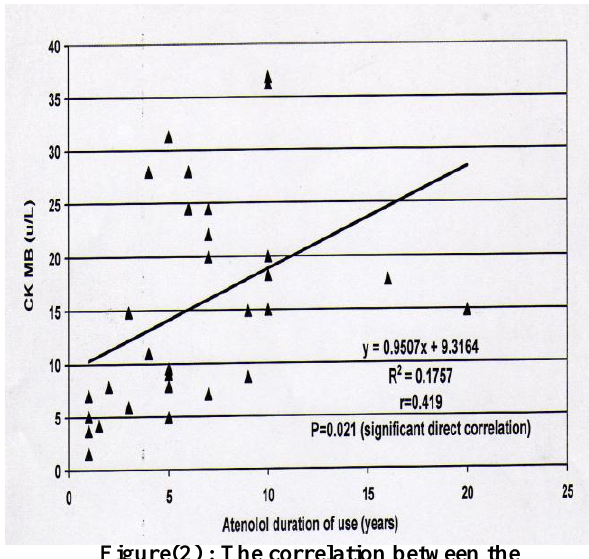
Figure(2) : The correlation between the duration of atenolol treatment (years) and CK-MB (u/L) in total 30 patients included in the